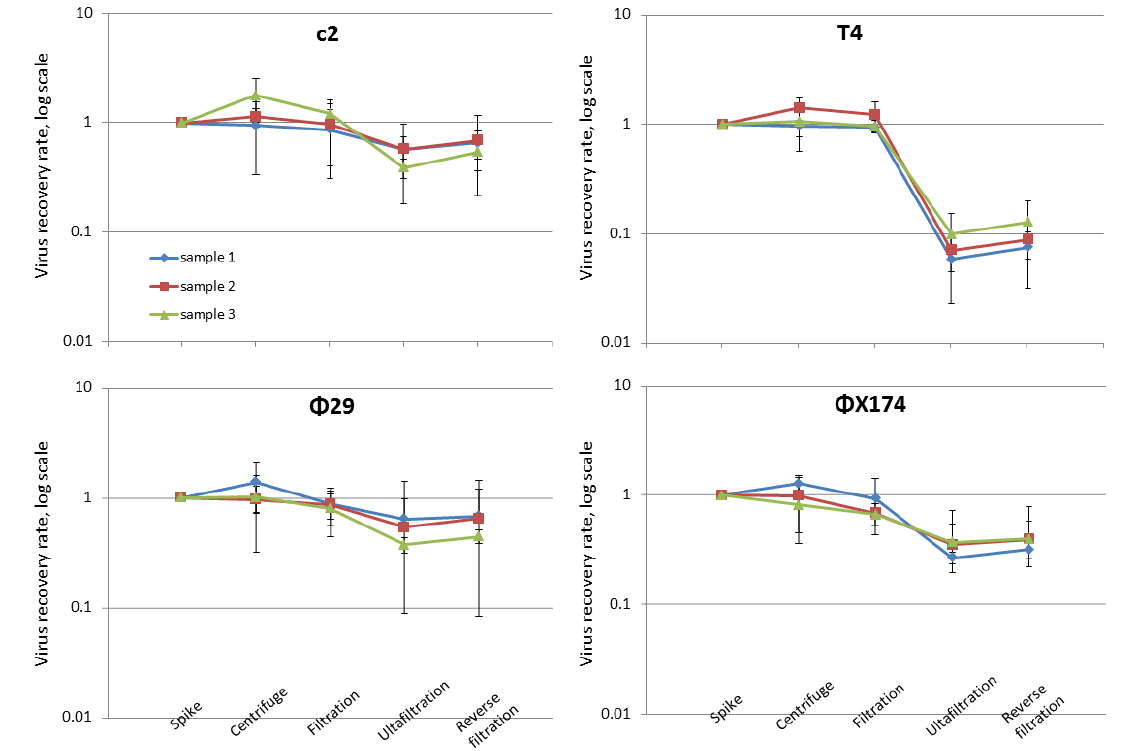
Figure 2. Infective phage recovery determined by plaque assays. The percentages of phages recovered (y axis) were determined by plaque assay at each different sampling point (x axis) . The error bars here indicate the standard deviation of 3 replicates.